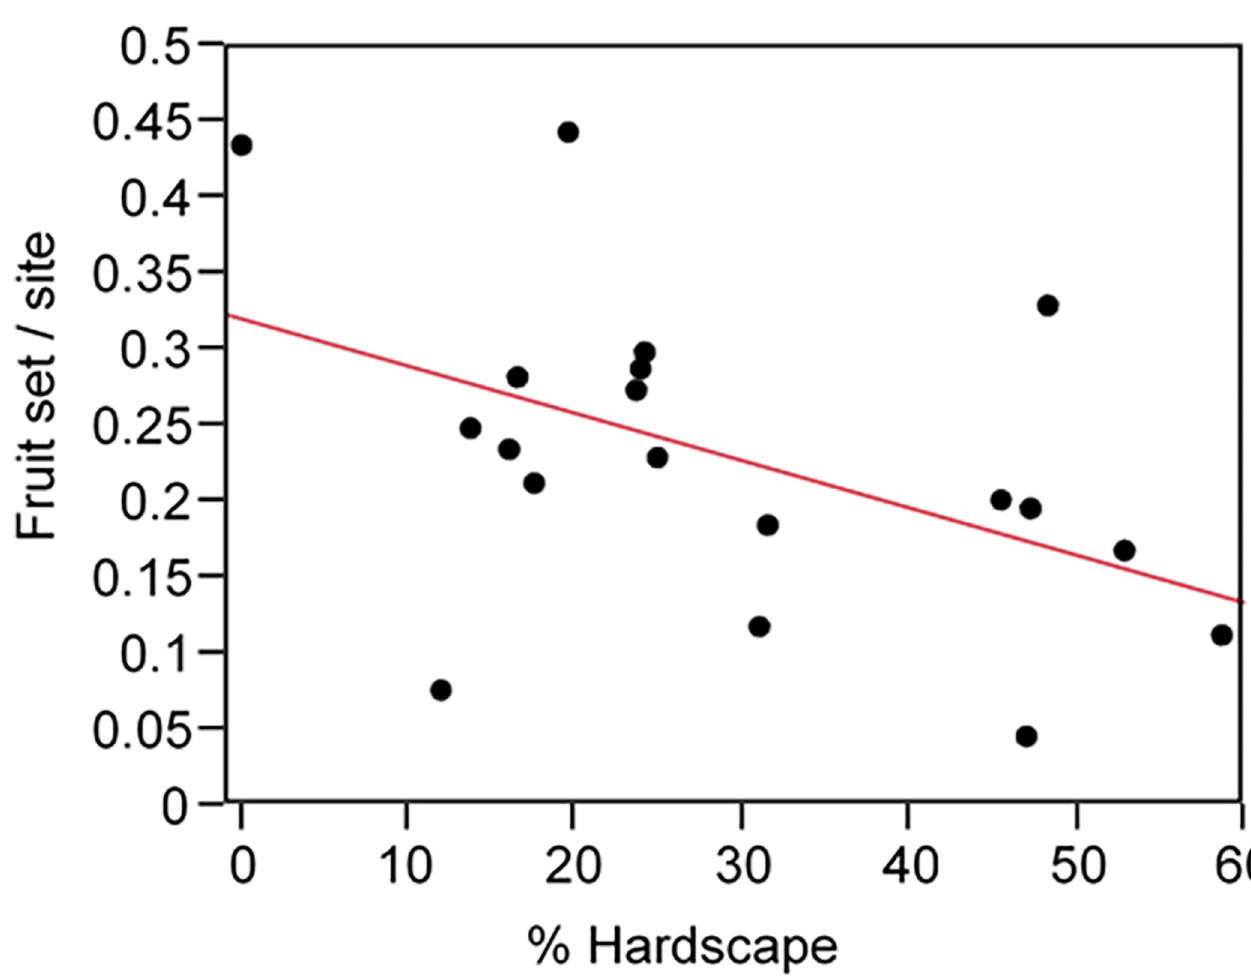
Fig 4. Linear regression showing the relationship between fruit set and percent hardscape. A significant negative correlation was found between fruit set measured using sentinel cucumber plants at each study site and percent hardscape (R 2 = 0.23; P = 0.038).